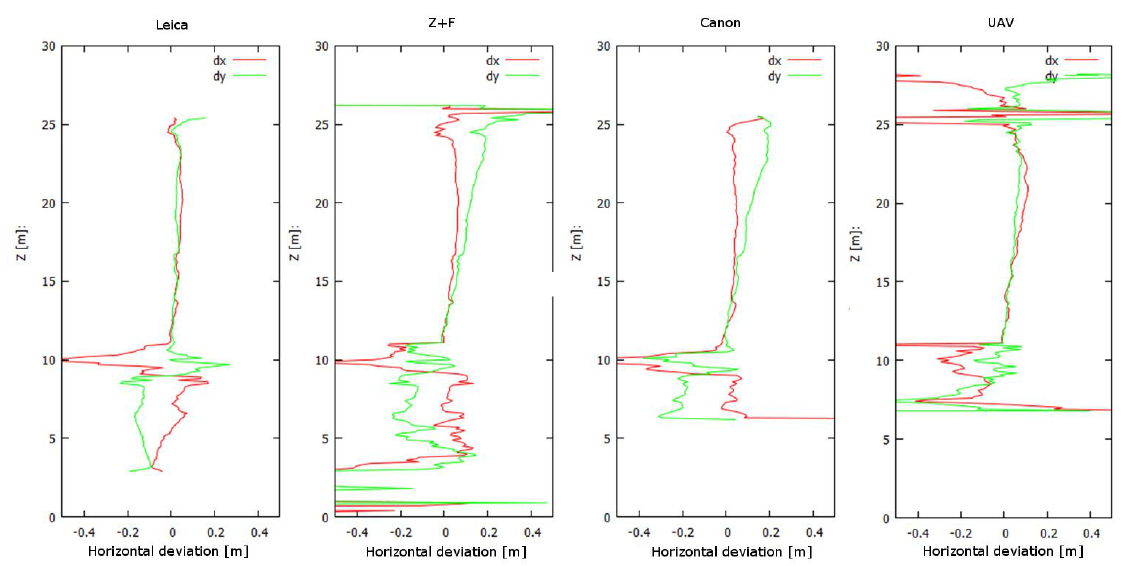
Figure 9: The diagram of the tower verticality based on data from different sensors